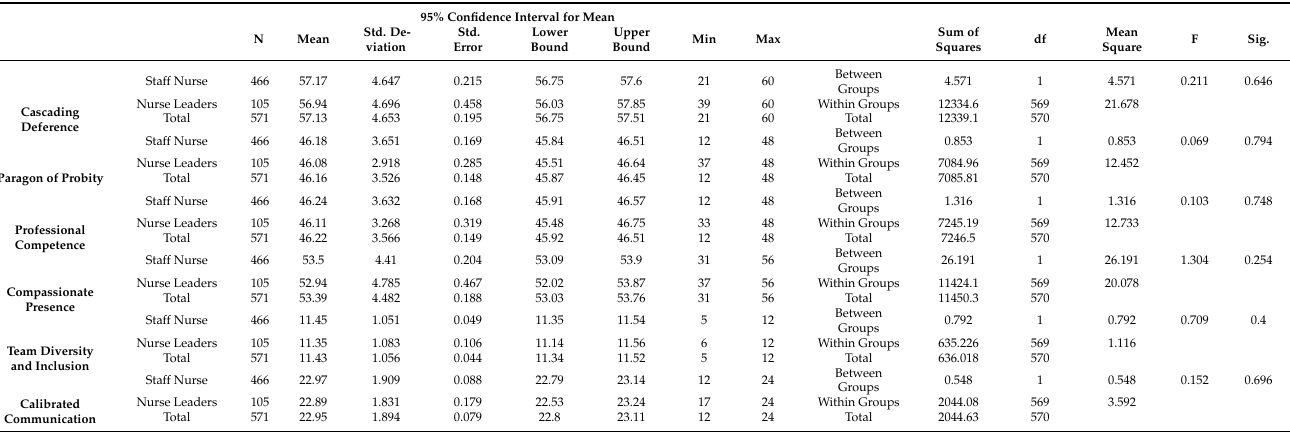
Table 5. Test of significant differences between the nurse leaders’ and staff nurses’ perceived values of nurse leaders ( n =